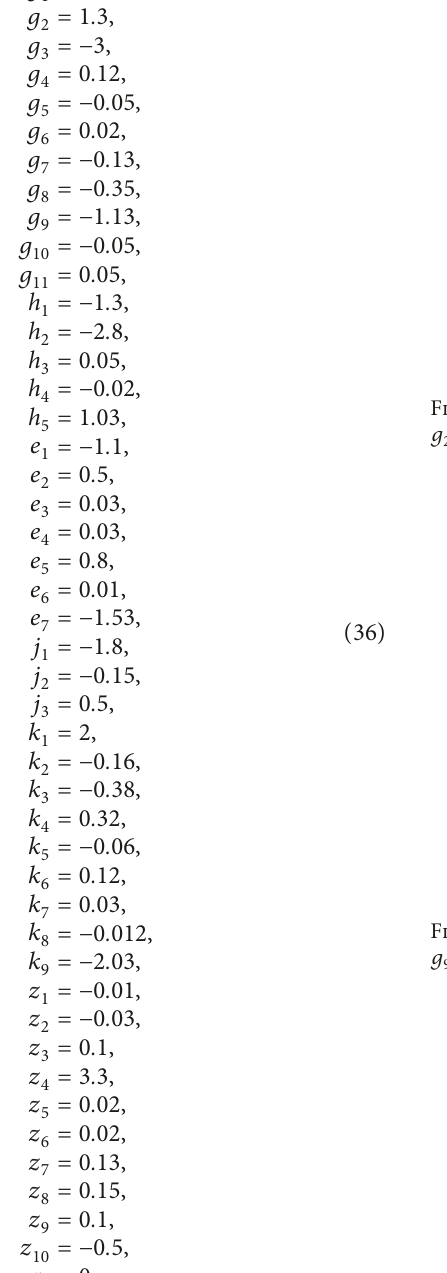
Figure 7: Frequency-response curves obtained when g � − 0 . 3, 2 j � − 0 . 8, and σ � 1 1 the same as in Figure 4. The big difference between Figures 6 and 5 is that there exists the softening-type nonlinearity in Figure 6 for the rotor-AMB system with 16-pole legs and the time-varying stiffness when σ changes in the range of ± 100. 2